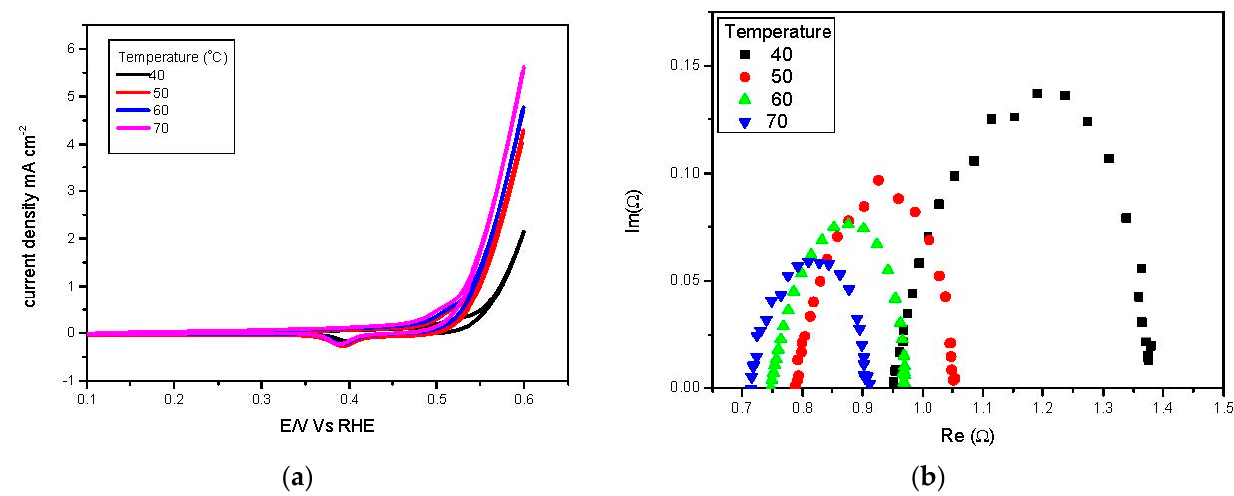
Figure 6. Effect of temperature on electrochemical performances ( a ) CV ( b ) EIS.